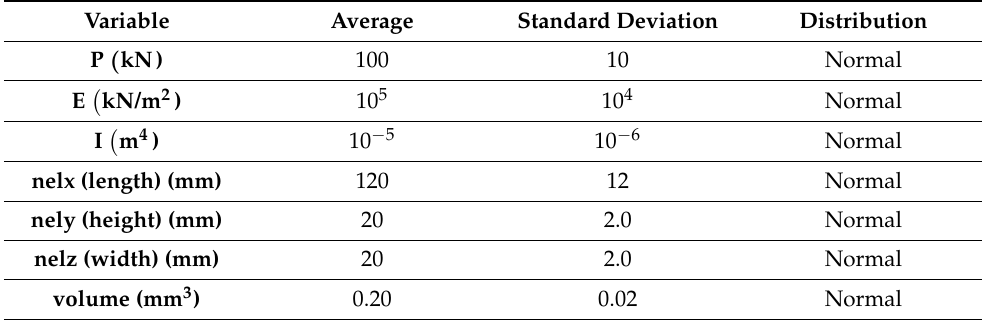
Table 3. Random variables for the MBB